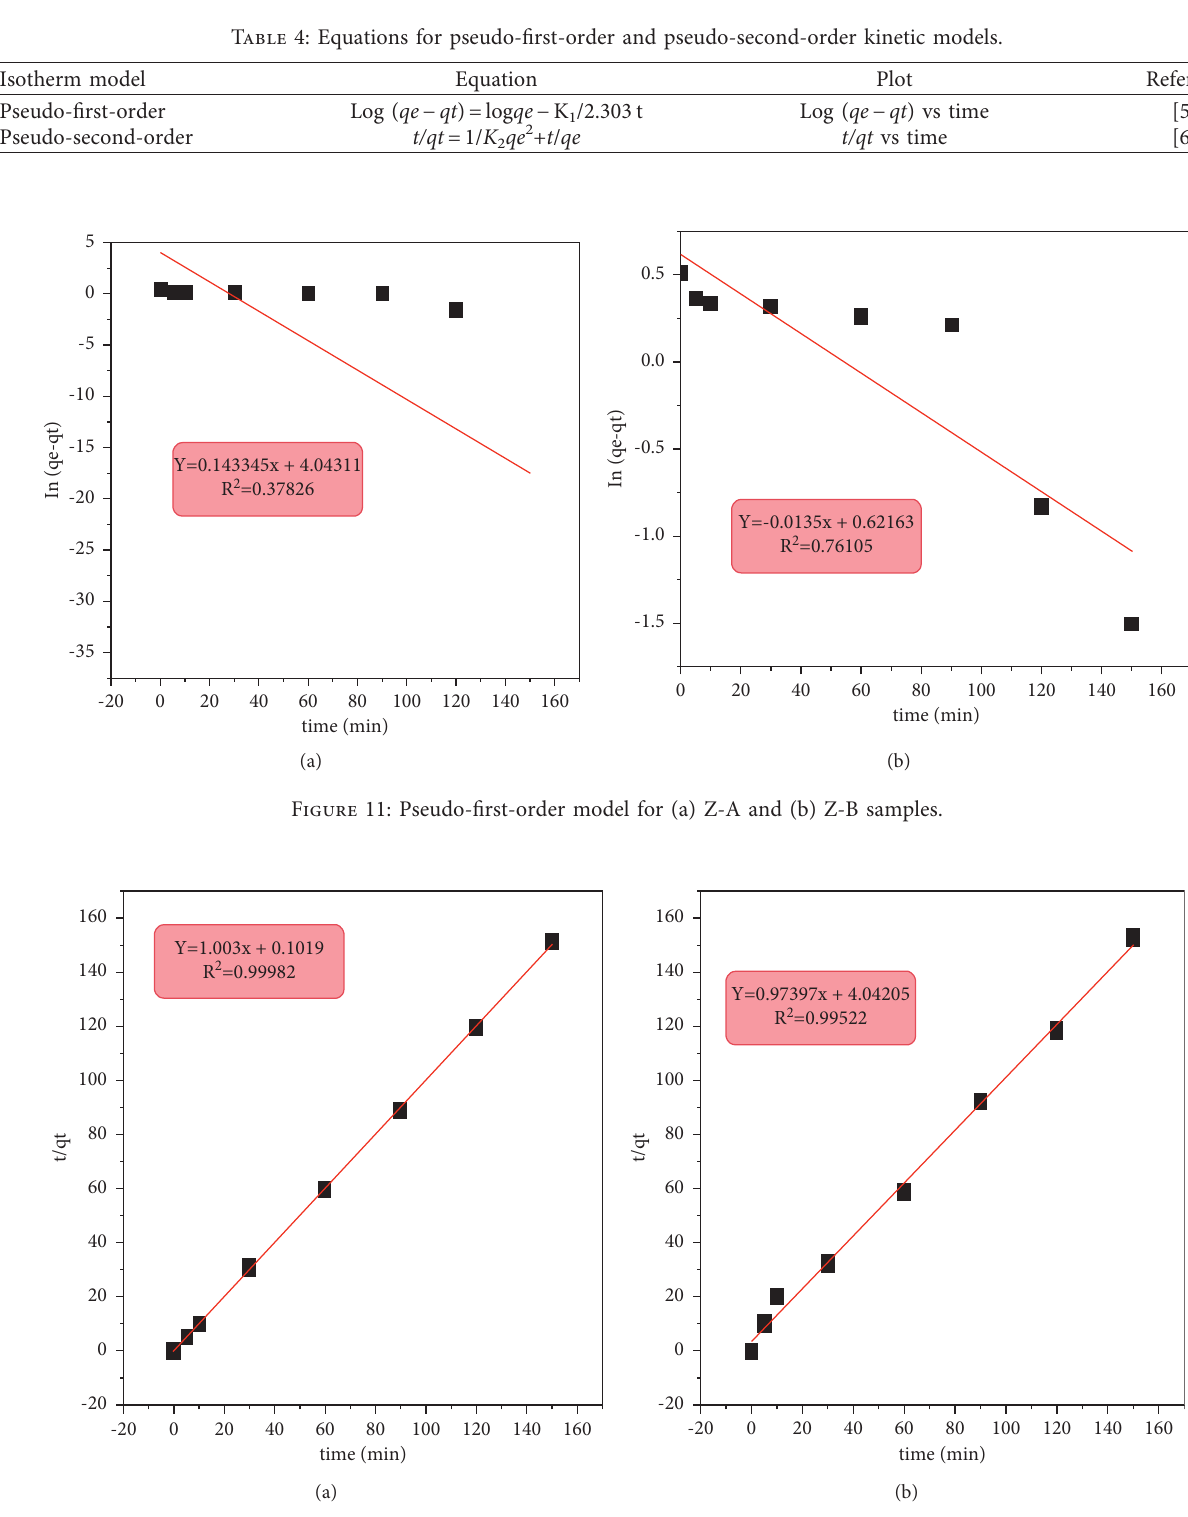
Figure 12: Pseudo-second-order model for (a) Z-A and (b) Z-B